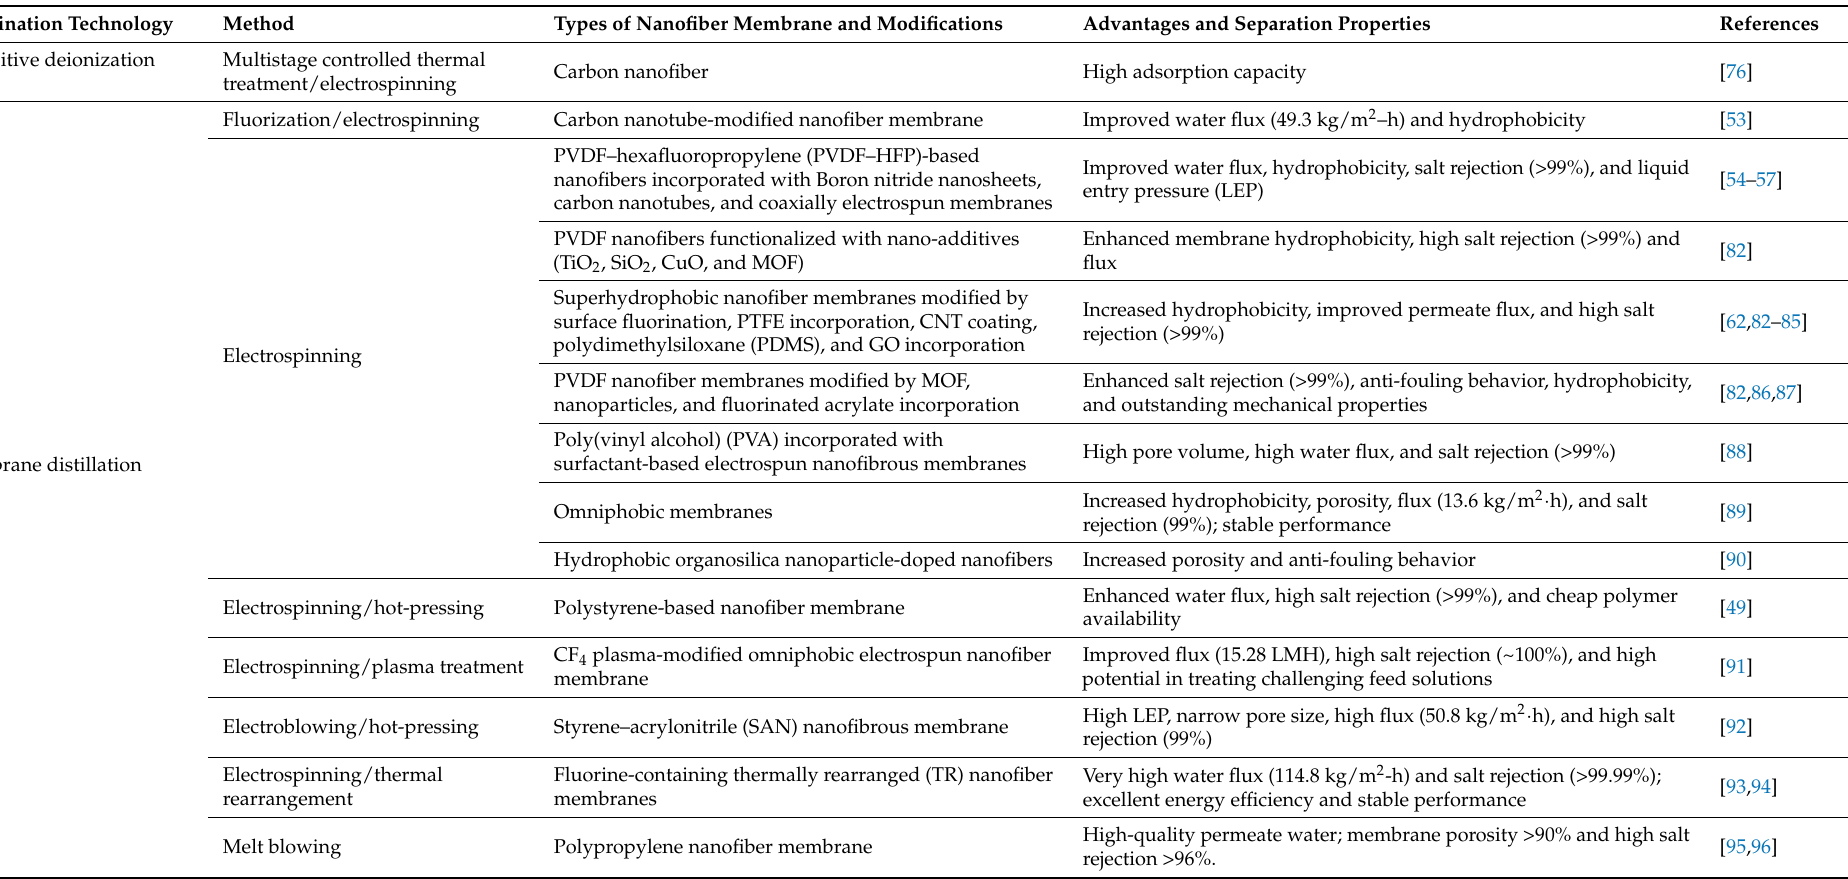
Table 2. Types of nanofiber membranes used for desalination of